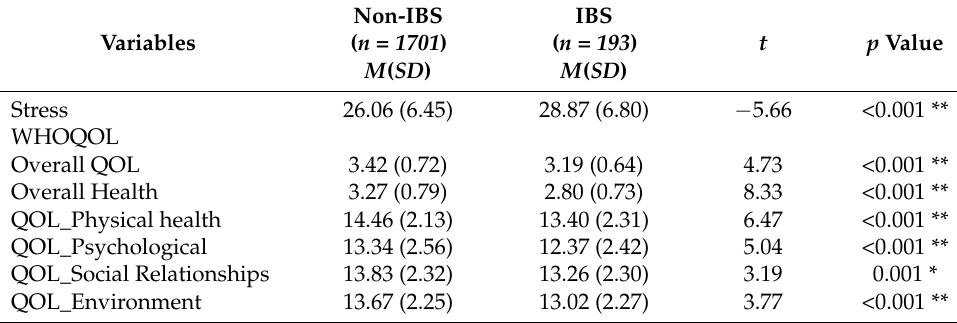
Table 3. The level of stress and quality of life between female students with and without irritable bowel